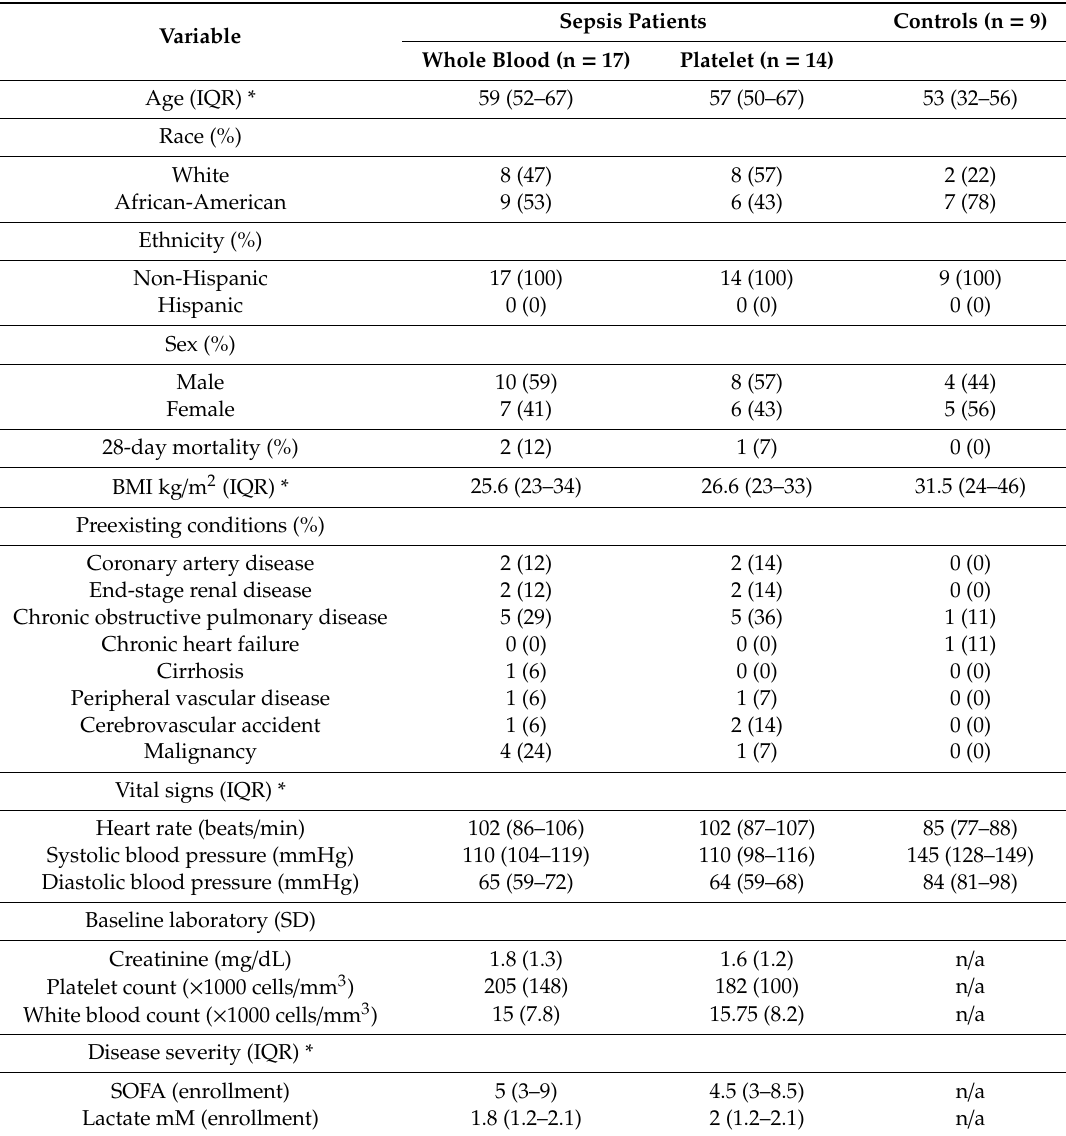
Table 1. Patient demographics and clinical